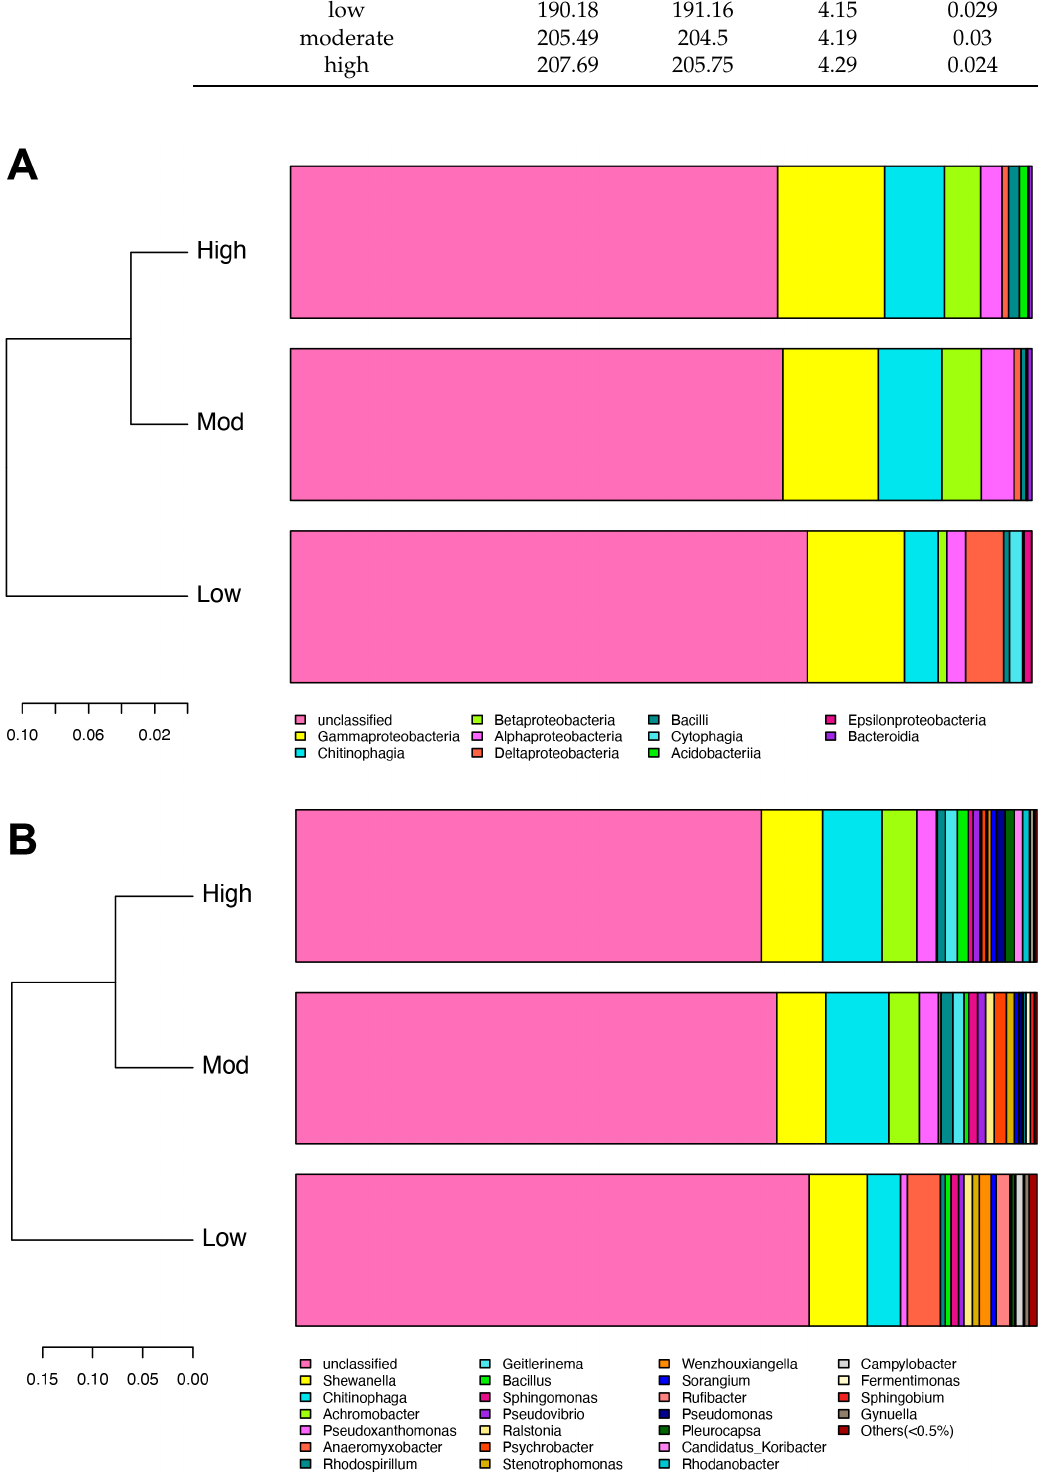
Figure 5. Effects of moso bamboo invasion on denitrifying bacterial community beta diversity. Barplots showing the denitrifying bacterial community composition at the class ( A ) and genus ( B ) levels. Weighted unifrac tree showing the distances of the identified denitrifying bacteria.